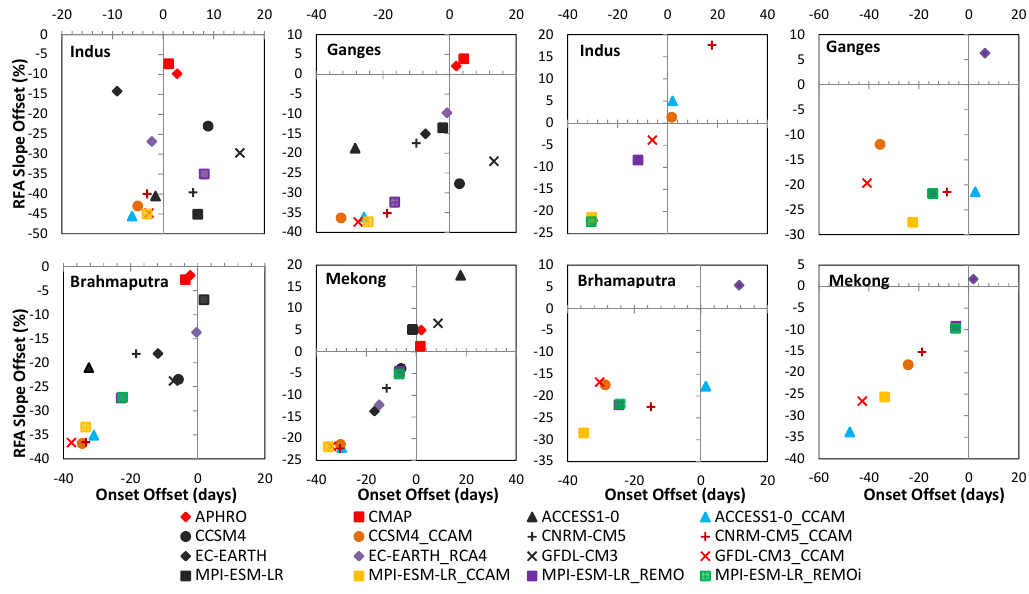
Figure 6. The offsets of rapid fractional accumulations (RFA) slopes against the suggested timings of the climatological monsoon onset from: all datasets relative to the GPCP observational dataset (left panel), the CX-SA relative to their driving CMIP5 datasets (right panel). Note: In the left panel, observations are shown in red whereas the driving CMIP5 GCMs (in black) and CX-SA (in different colors) are shown with the same marker shape. The positive values indicate a delayed onset or an overestimation of RFA slope while negative values indicate the